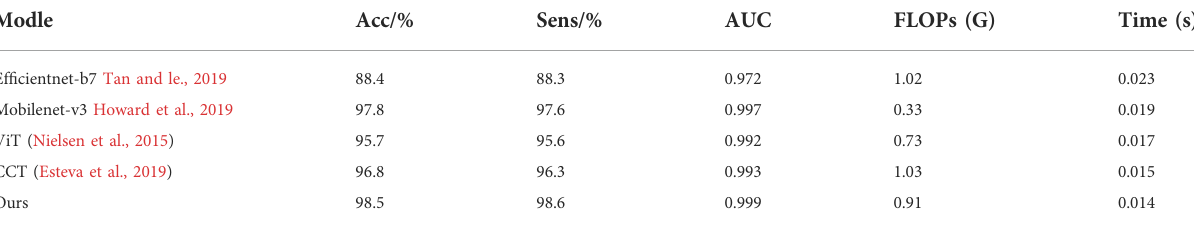
TABLE 2 Performance comparison of different